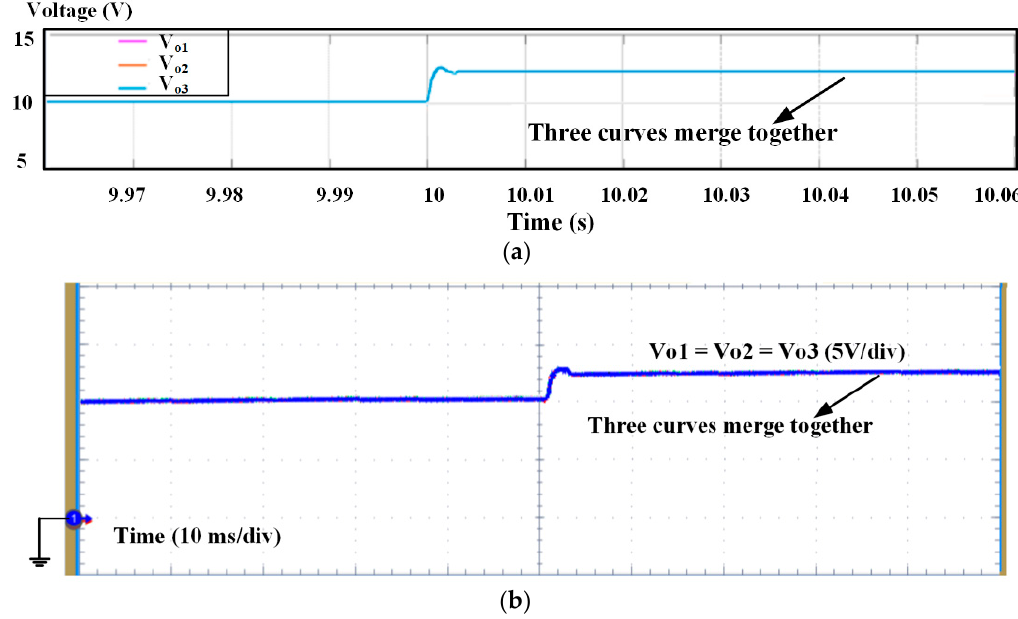
Figure 11. Waveforms for three battery module output voltage when bus reference voltage changes from V bus-ref = 30 V to V bus-ref = 37.5 V, ( a ) simulation results and ( b ) hardware experimental results.